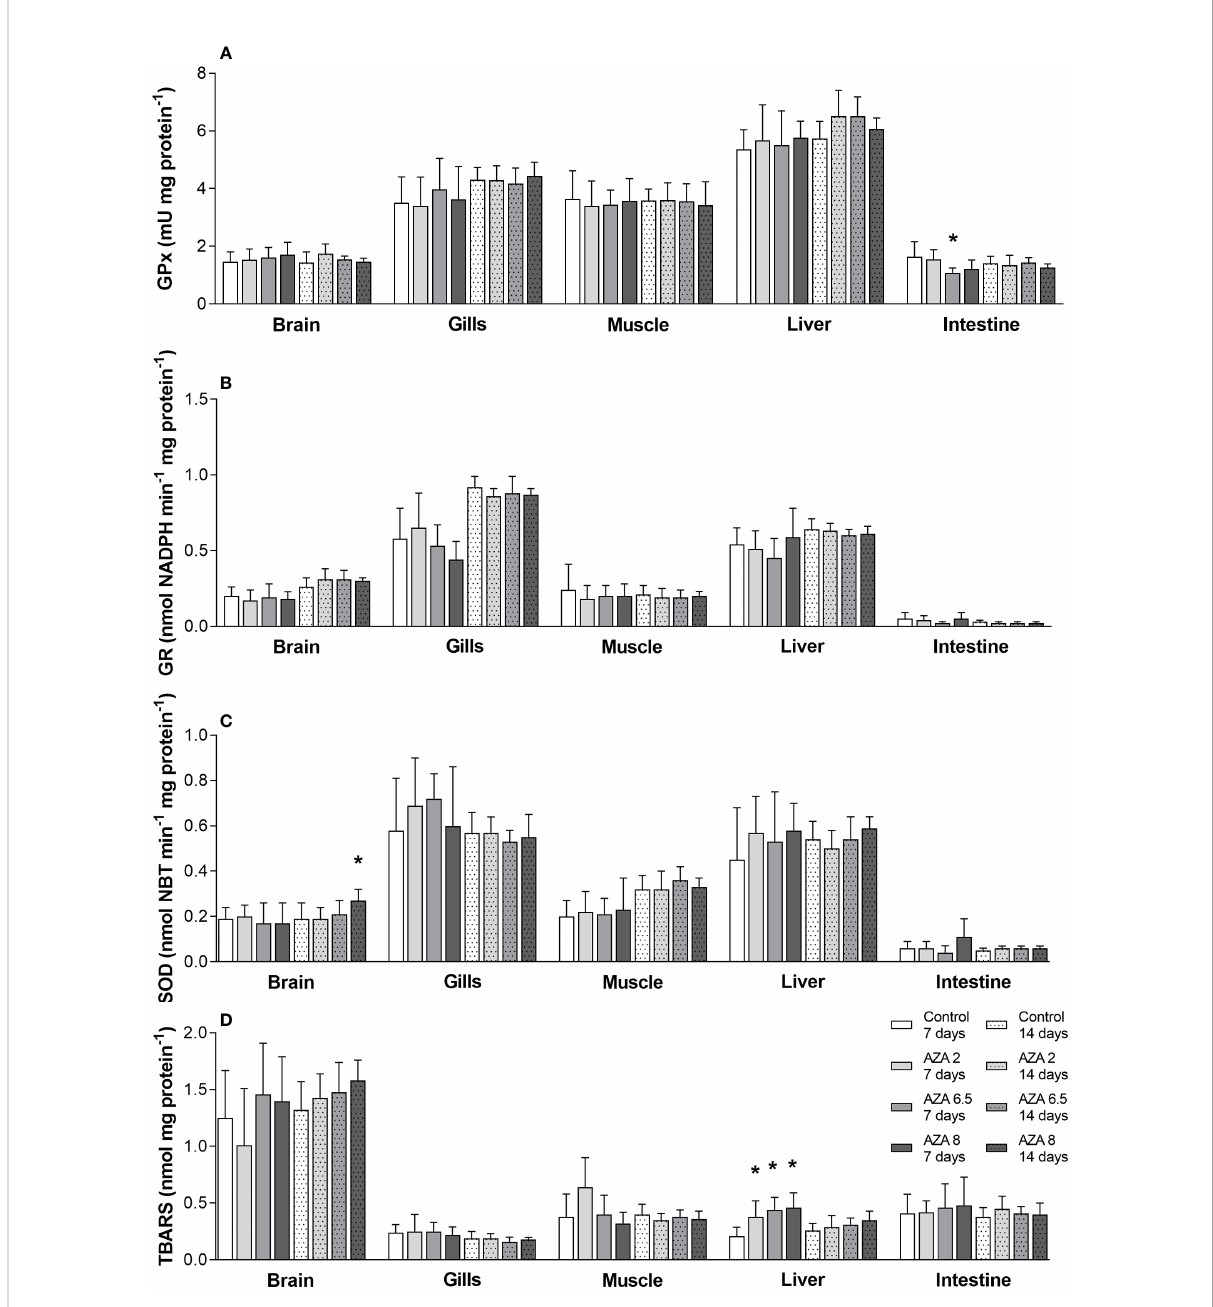
FIGURE 5 The mean ± SD concentrations of: (A) glutathione peroxidase; (B) glutathione reductase; (C) superoxide dismutase; (D) thiobarbituric acid reactive substances in the brain, gills, muscle, liver, and intestine of Nile tilapia exposed to 0, 2, 6.5, and 8 mg L -1 after 7 days and after recovery period (at the end of 14 days); asterisk denotes statistically signi fi cant difference (one way ANOVA followed by Tukey ’ s post hoc test; P < 0.05) between control and exposed